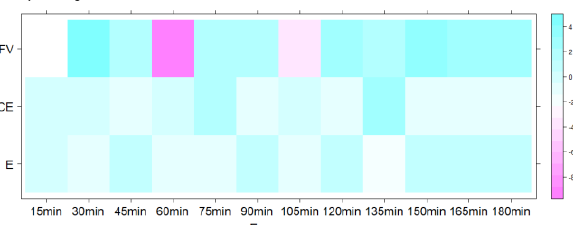
Figure 8. Levelplot of Entropy (E), Conditional Entropy (CE) and Function Value (FV) across the entire range of